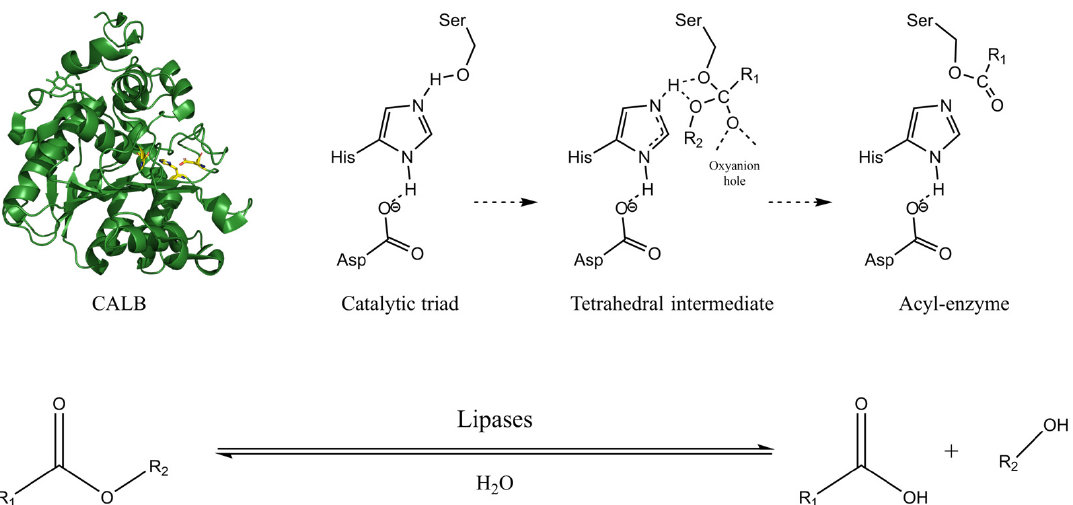
Figure 5. Mechanism of the hydrolysis reaction of ester bonds catalyzed by lipases. The Asp-His- Ser catalytic triad of CALB (PDB entries 4ZV7) [80] is represented by the red, yellow, and blue ball-and-sticks. The copyright detail is shown in supplementary material.